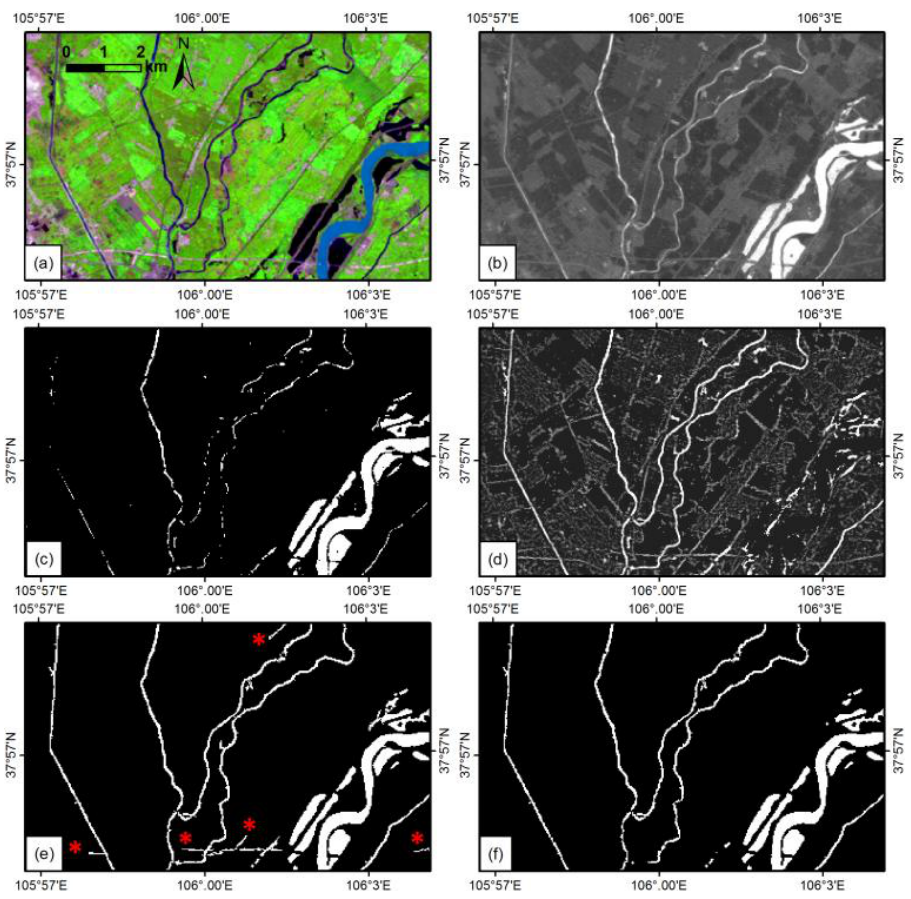
Figure 5. Results of several important steps in the AMERL. The images depict a portion of study area 3. ( a ) TM 543 band false-color image; ( b ) MNDWI; ( c ) results of the optimal thresholding method for comparison; ( d ) linear feature enhancement (LFE); ( e ) results of the AMERL without road (red-asterisk) reduction; ( f ) final results of the